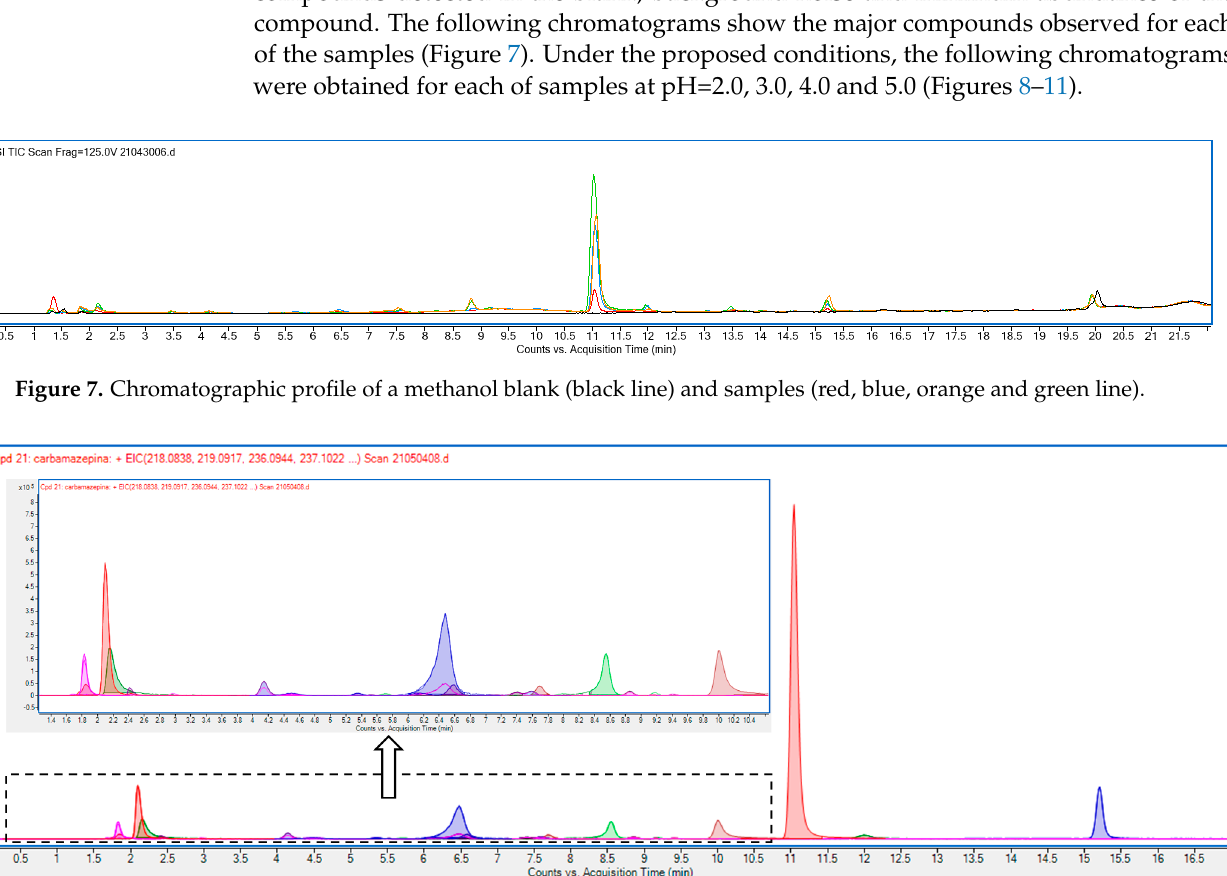
Figure 8. Chromatographic profile of the major compounds detected in the sample of carbamazepine oxidized to pH = 2.0. Experimental conditions: (CBZ) = 50.0 mg/L; (Fe) = 10 mg/L; (H 2 O 2 ) = 15.0 mM; T = 25 °C; (UV) = 150 W.